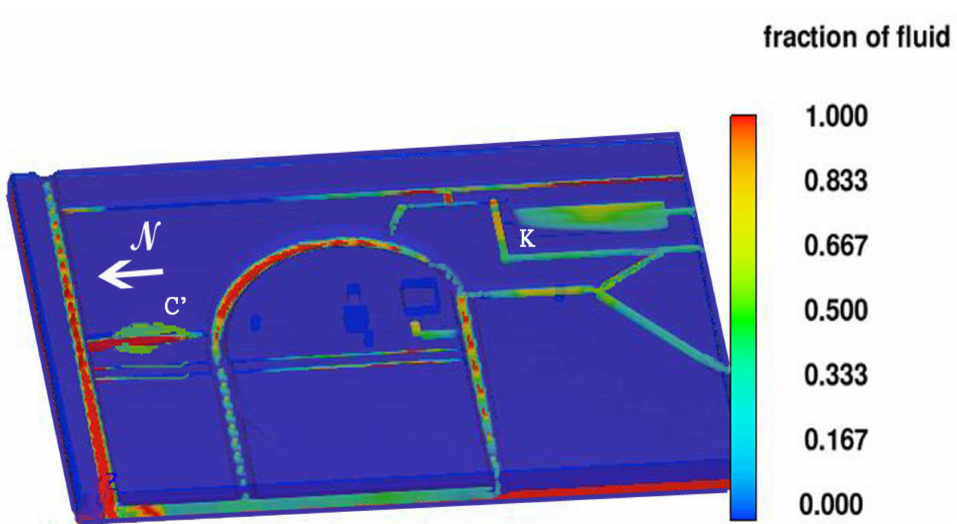
Figure 9. Dry season (Case 2) fluid fraction results on a plane below the ground surface; moisture levels in qocha region K and depressed area C’ indicate sustainable pasturage and agriculture due to contact with the deep-water table and discharge from the V arm of the perimeter drainage channel. Water input from canal M delivers water to the perimeter drainage channel that enters subterranean channels P and Q.